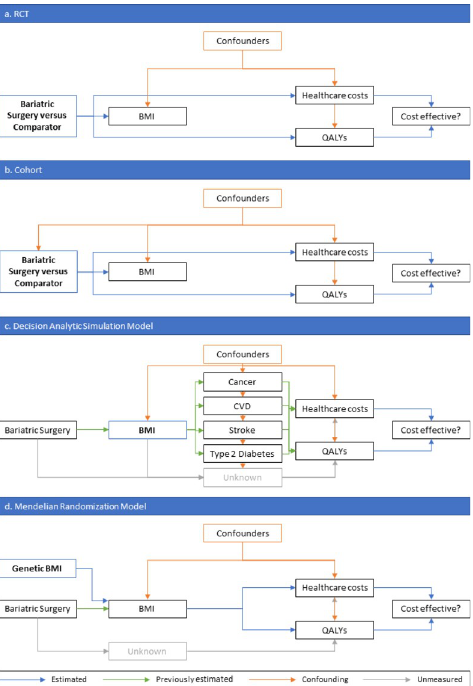
Fig 1. Schematic representation of different methods of estimating cost-effectiveness of bariatric surgery. The intervention or exposure for each analysis is in the blue box with bold text. Blue arrows represent what is estimated in each study, while green arrows represent estimates from previous studies used to inform the study. ( a ) The estimate of cost-effectiveness is not confounded as the intervention is randomised. ( b ) The estimate of cost-effectiveness could be confounded as receiving bariatric surgery is not randomly assigned. ( c ) The estimate of cost-effectiveness could be confounded, as could be the estimates from previous studies, there may be effects of bariatric surgery on QALYs and healthcare costs that do not go through BMI, and there may be effects of BMI on QALYs and healthcare costs that do not go through the modelled health conditions. ( d ) the estimate of cost-effectiveness is less likely to be affected by confounding, as genetic variants are randomly distributed within families at conception, though there may be effects of bariatric surgery on QALYs and healthcare costs that do not go through BMI. BMI, body mass index; CVD, cardiovascular disease; QALY, quality-adjusted life year; RCT, randomised controlled